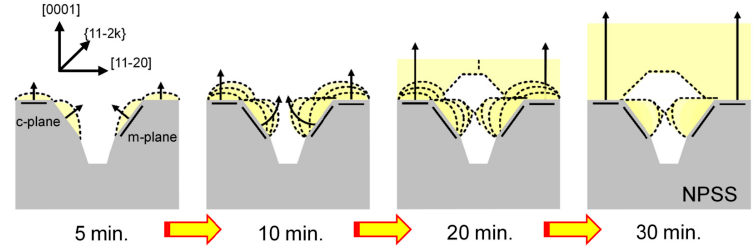
Figure 6. AFM measurement of AlGaN grown on a NPSS at growth times of 5, 10, 20, and 30 min.